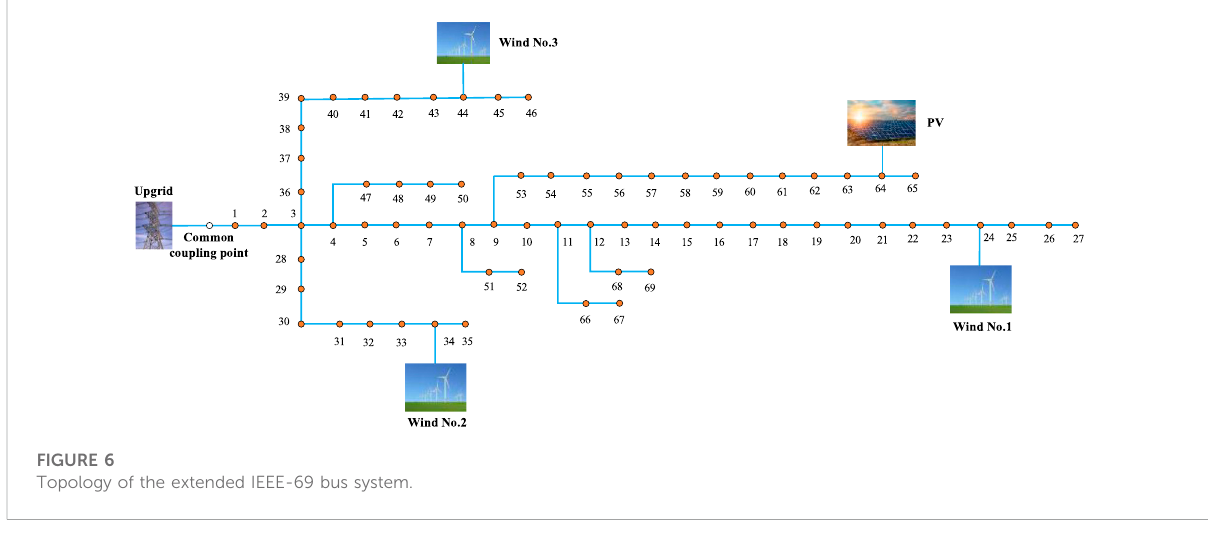
FIGURE 6 Topology of the extended IEEE-69 bus system.